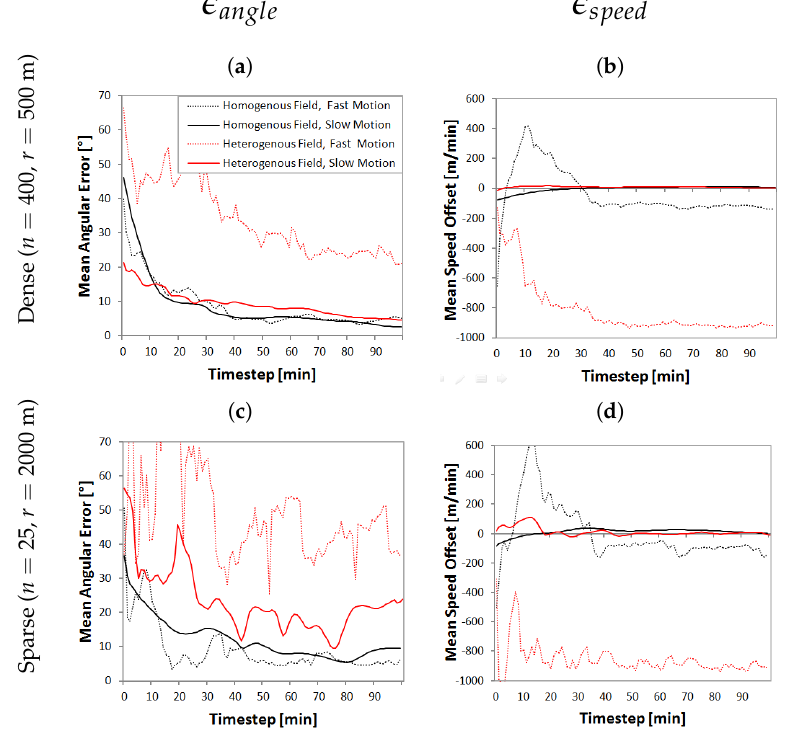
Figure 5. Comparison of the angular error and speed offset for different motion speeds and the two field types. ( a ) Mean angular error per time step for n = 400 and r = 500 m; ( b ) mean speed offset per time step for n = 400 and r = 500 m; ( c ) mean angular error per time step for n = 25 and r = 2000 m; ( d ) mean speed offset per time step for n = 25 and r = 2000